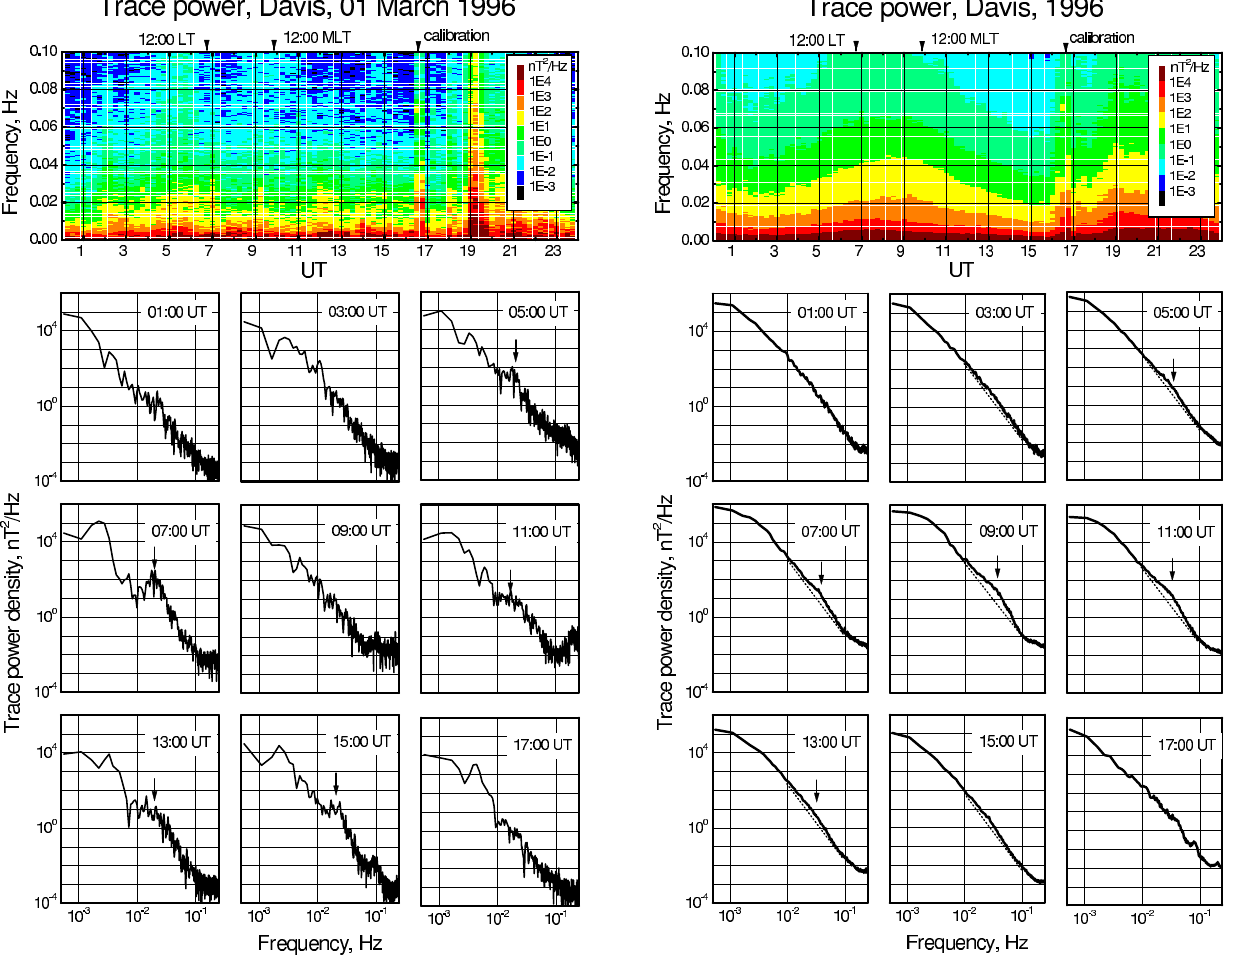
Fig. 1. Example of cusp latitude diurnal spectrogram (top panel) and selected power spectra (nine bottom panels) for 01 March 1996. Arrows show approximate positions of band-limited spectral en- hancements (“bumps”) in Pc3–4 range.